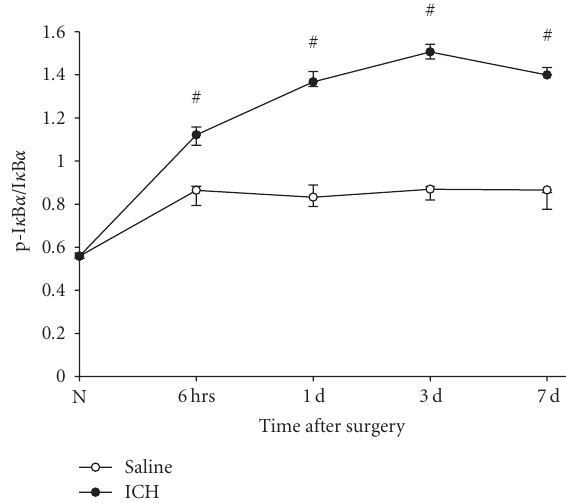
Figure 5: The increased phosphorylation of inhibitor of kappa - Bα ( p - IκBα ) in brain after ICH . The expression of p- I κ B in brain tissue was measured by the method of Western Blots using specific antibodies for p-I κ B α and I κ B α . The signals were quantified by scanning densitometry and computer-assisted image analysis and expressed as the ratio of p-I κ B α to I κ B α . The results showed that the p-I κ B increased at 6hours after ICH ( P < . 05), peaked on 3 days after ICH and maintained a high level on 7 days after ICH ( P < . 05). #: compared with saline control, P < .